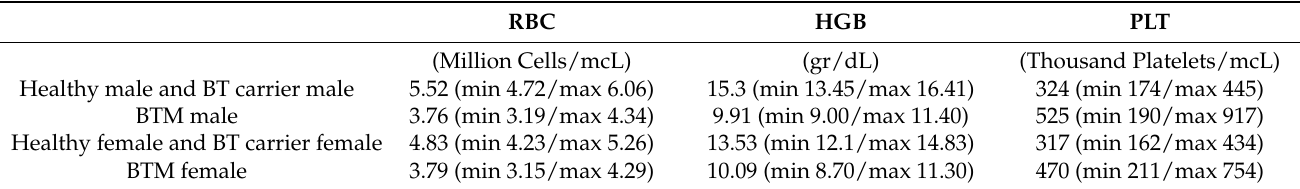
Table 2. Mean values with minimum and maximum values for RBC, HGB, and PLT values of the participants.